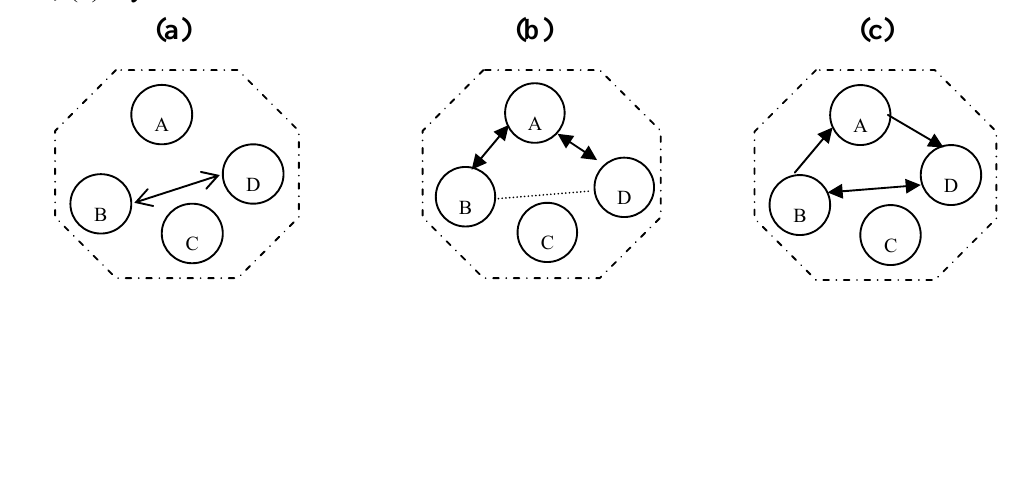
Figure 2 . Clustering Connection Protocol (a) Cluster S Direct connection; (b) Indirect connection; (c) Hybrid